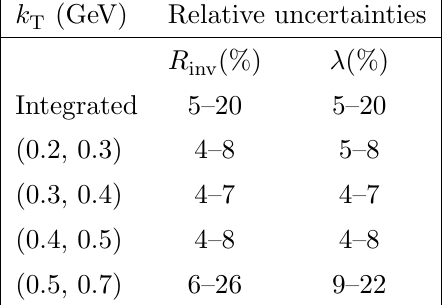
bins for the hybrid cluster subtraction T